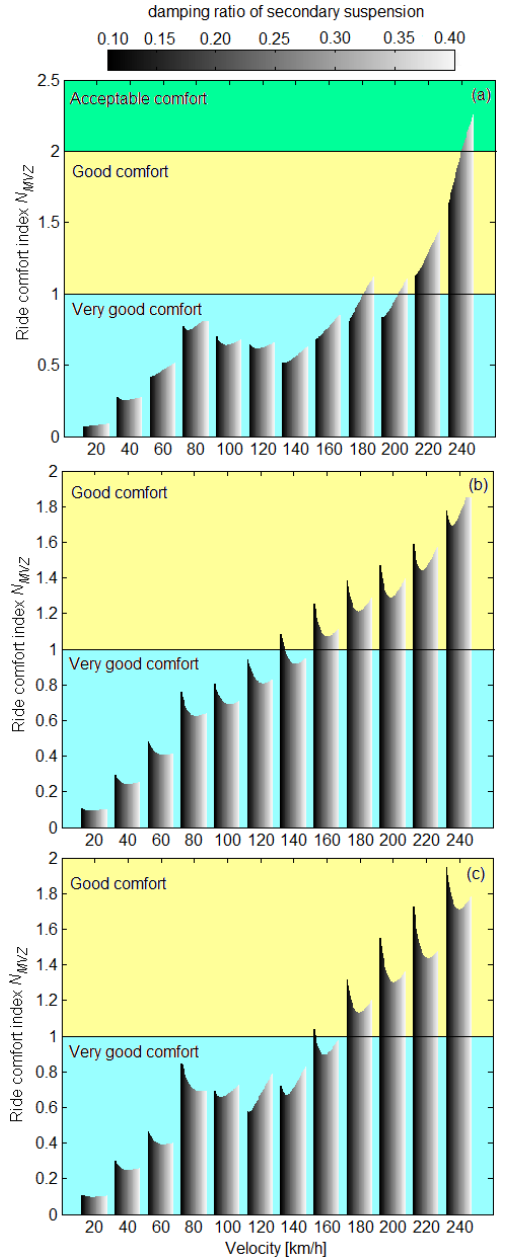
Figure 15. Ride comfort index N MVZ depending on the damping ratio of secondary suspension: ( a ) in point C ; ( b ) in point B 1 ; ( c ) in point B 2 .